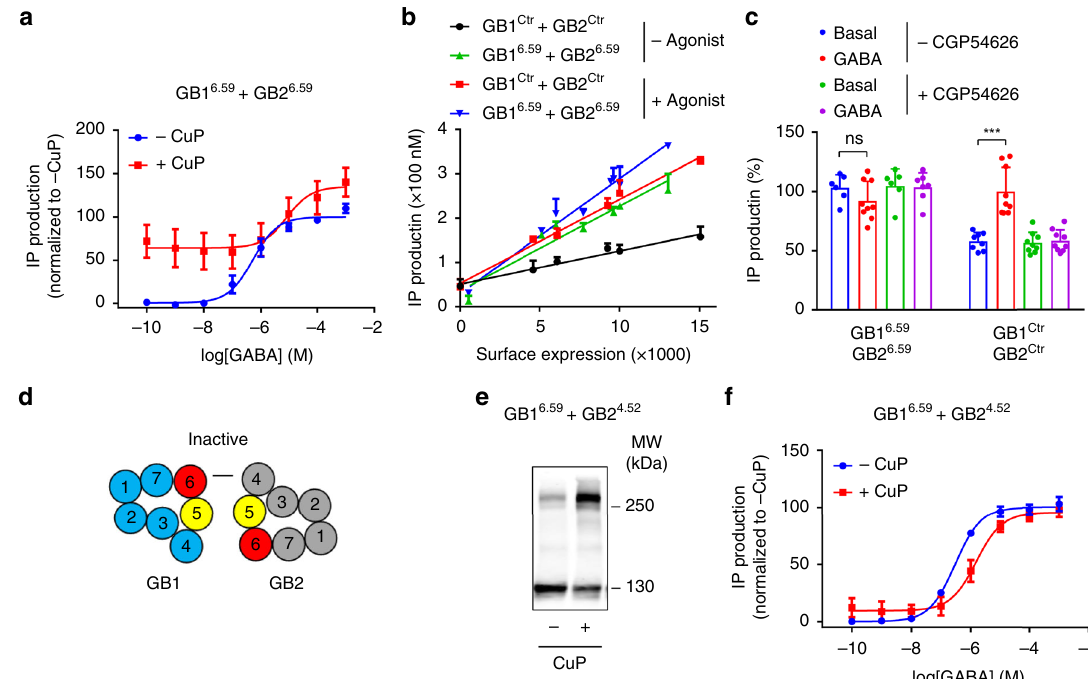
Fig. 4 Disul fi de cross-linking con fi rms the GB1-GB2 TM6 active interface and the resting interface. a Inositol phosphate (IP) production in cells that co- express the mutants GB1 6.59 and GB2 6.59 after treatment with or without CuP, and stimulation with GABA. Results are mean ± SD from three independent experiments performed in triplicates. b In both the control receptor (after stimulation with GABA) and the co-expressed mutants GB1 6.59 and GB2 6.59 , IP production is proportional to the amount of SNAP-tagged GB1 at the cell surface, as measured by fl uorescence after labelling with SNAP-Red substrate and then treatment with CuP. GABA was used at 100 μ M. Data are mean ± SD from a typical experiment performed three times. c Treatment with the indicated competitive antagonist does not reverse the constitutive activity after GB1-GB2 TM6s cross-linking. GABA and CGP54626 were used at 1 and 10 μ M, respectively. Data are mean ± SEM from a typical experiment performed three times. Unpaired t test with Welch ’ s correction with * P < 0.1, ns , not signi fi cant. d – f Stabilizing the inactive GB1-GB2 interface ( d ) by co-expressing the indicated mutants that cross-link well upon CuP treatment ( e ), impairs IP accumulation induced by GABA ( f ). Data are mean ± SD from a typical experiment performed three times